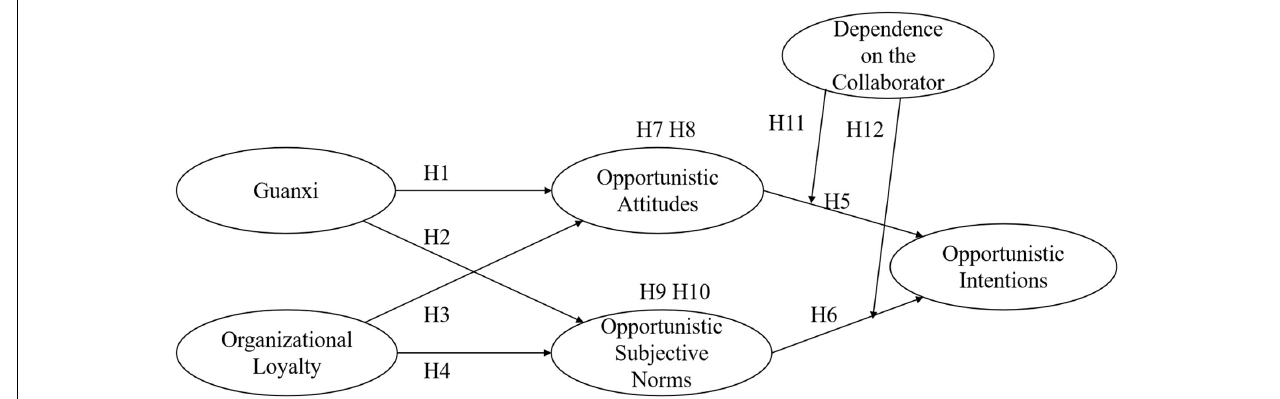
FIGURE 1 | Theoretical framework.